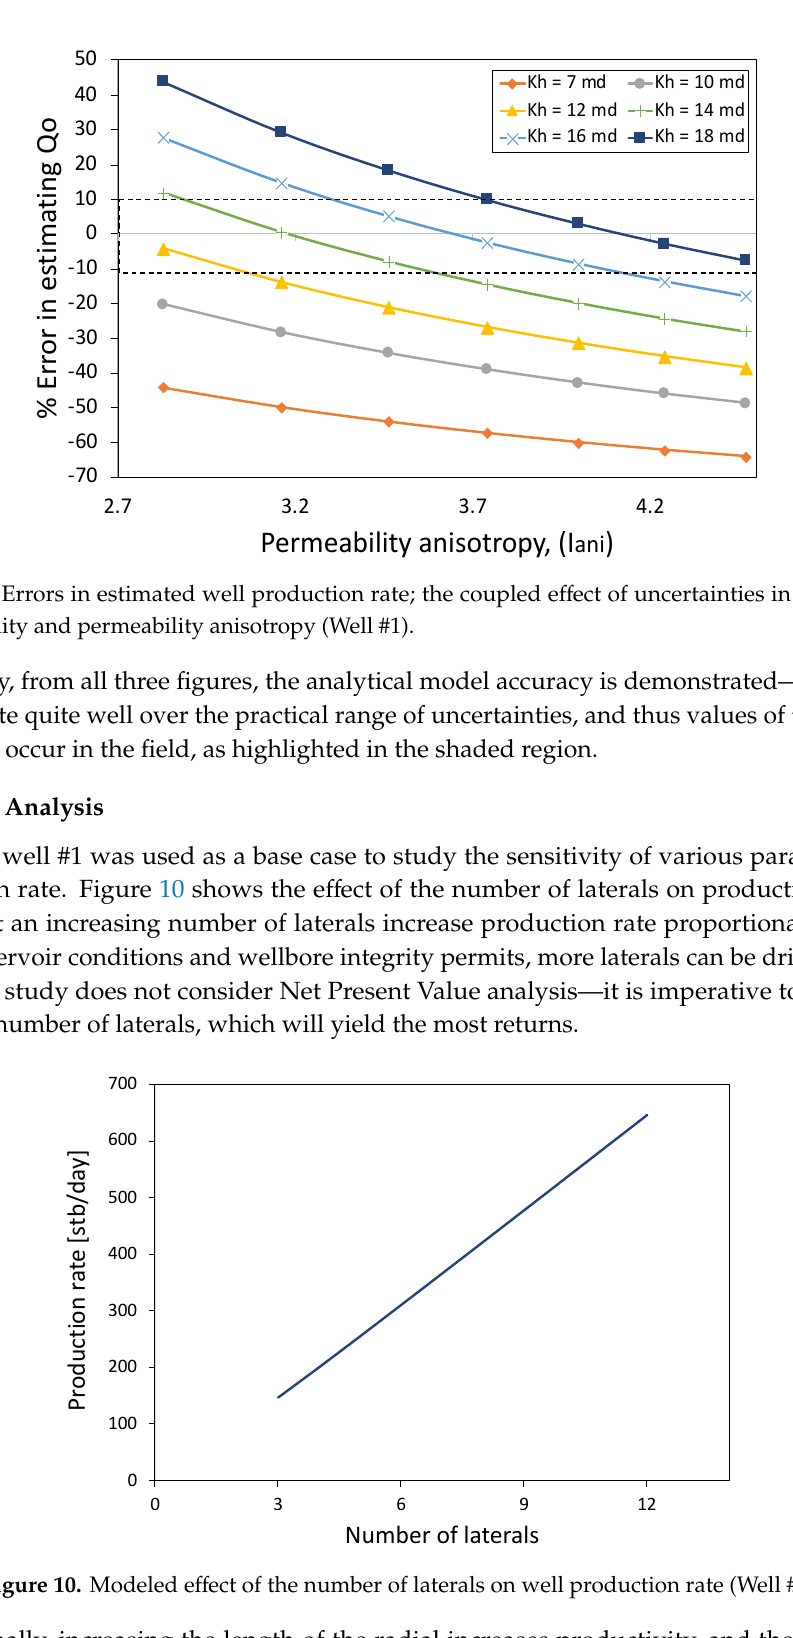
Figure 8. Errors in estimated well production rate; the coupled effect of uncertainties in bottom-hole pressure and permeability anisotropy (Well #1).